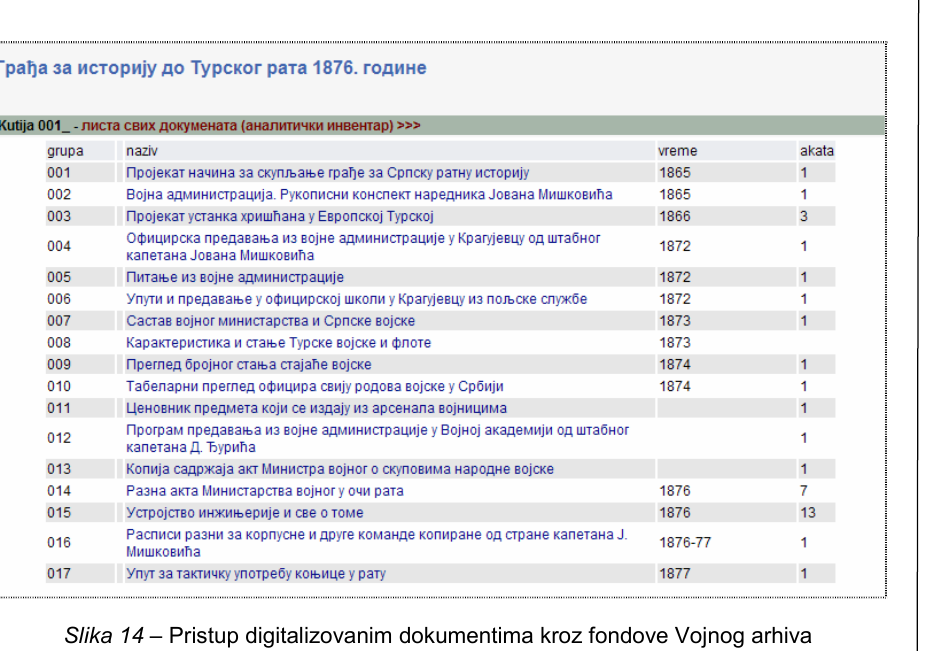
Figure 14 – Access to digitized documents through the Military Archives